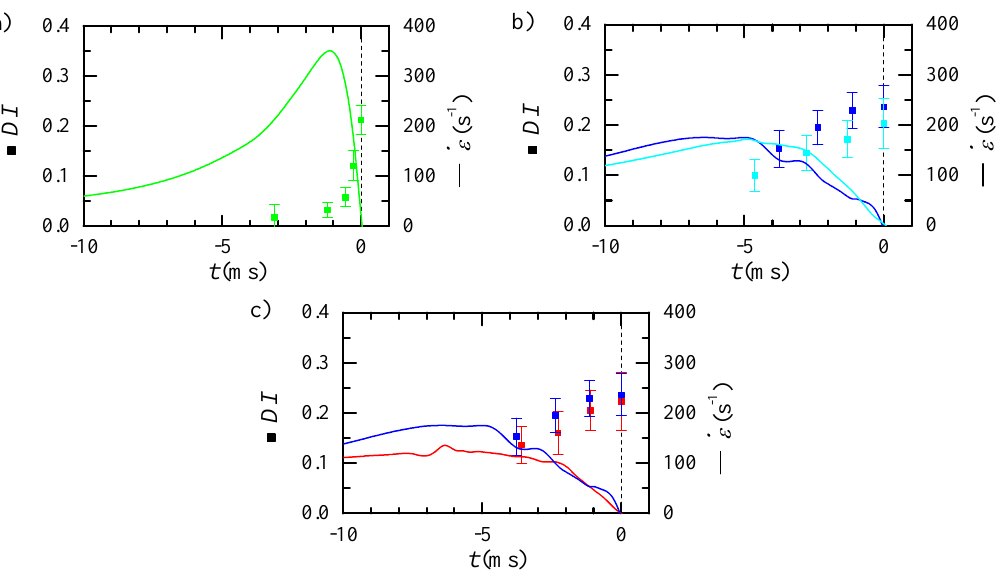
Q = 3 µ L/min (orange). The strain rate peak has to be applied more than 5 ms before the neck, to measure the maximum deformation at that section.